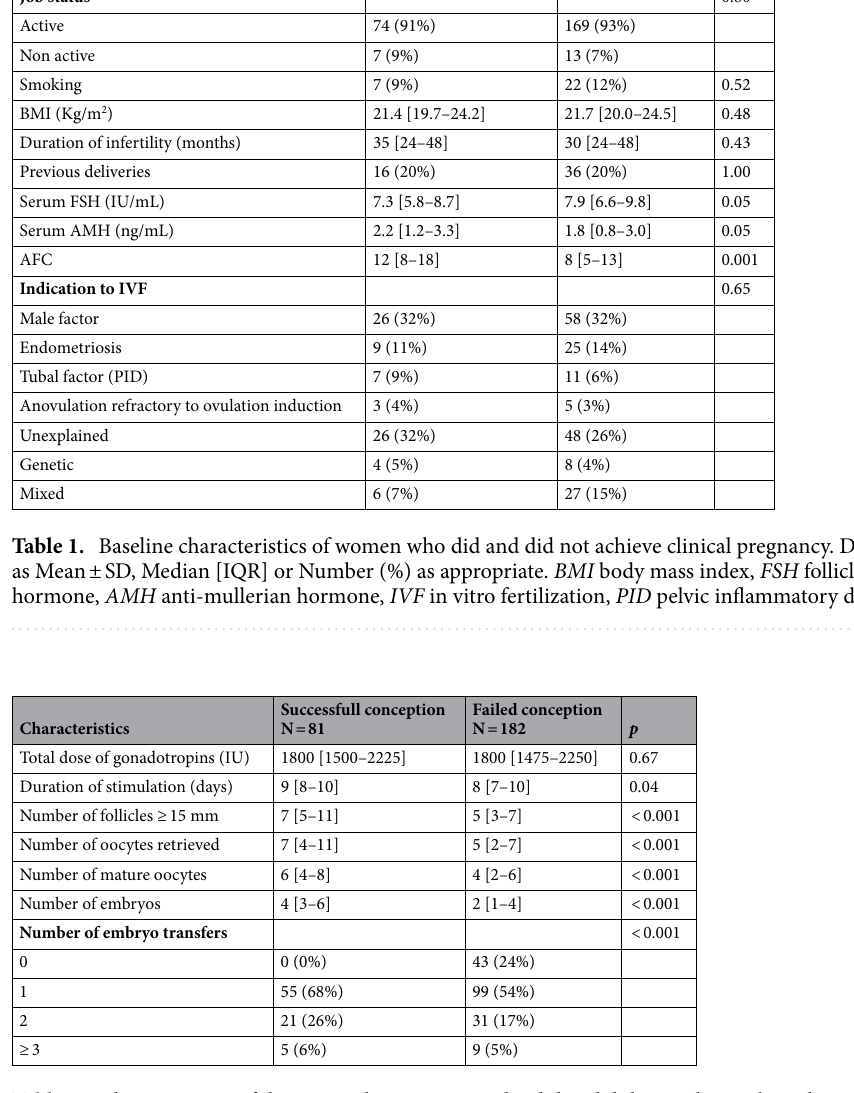
Table 2. Characteristics of the IVF cycles in women who did and did not achieve clinical pregnancy. Data is reported as Median [IQR] or Number (%) as appropriate. BMI body mass index, FSH follicle stimulating hormone, AMH anti-mullerian hormone, IVF in vitro fertilization, PID pelvic inflammatory disease.